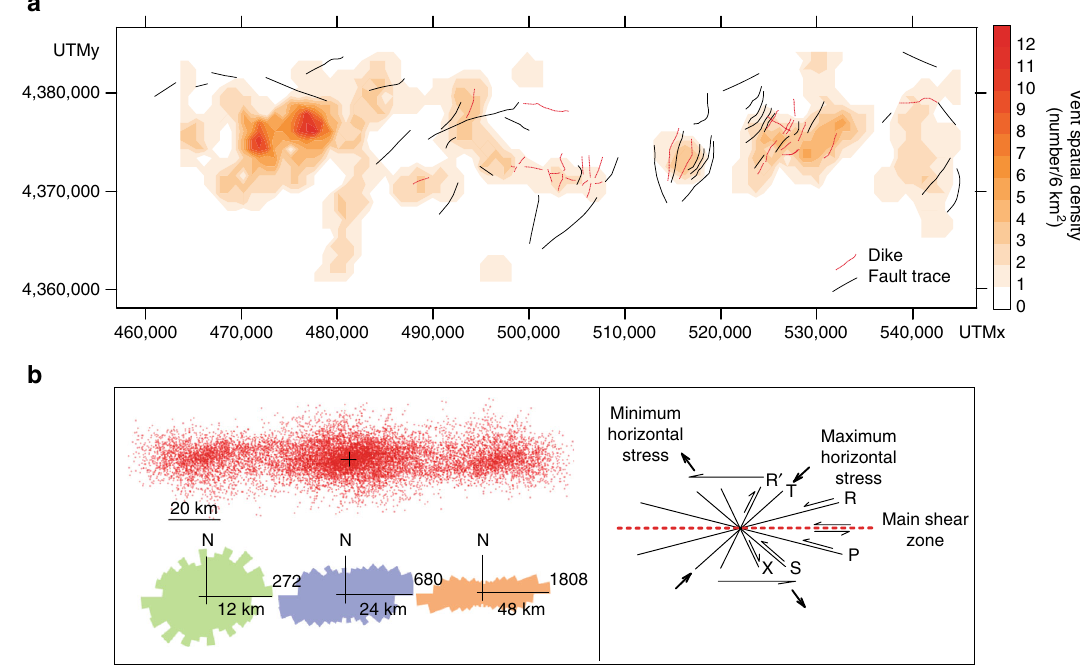
Fig. 5 Spatial and structural relations between vents and faults. a Spatial density of the vents reported in Fig. 2b with the dikes and faults. b Results of the Fry ’ s analysis 27 (red points) of the vents reported in Fig. 2b, and rose diagrams of the alignment of the points as a function of the distance from the center of the distribution; theoretical orientation and slip directions of R , R ′ , P , X , and Y secondary shears relative to a main, sinistral shear zone according to ref.